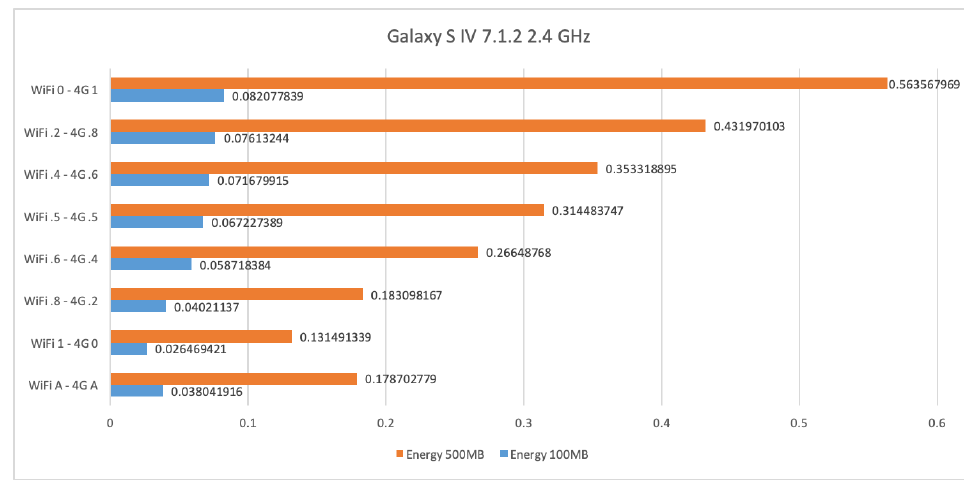
Figure 13. WiFi at 2.4 GHz and 4G energy consumption results for the Samsung Galaxy